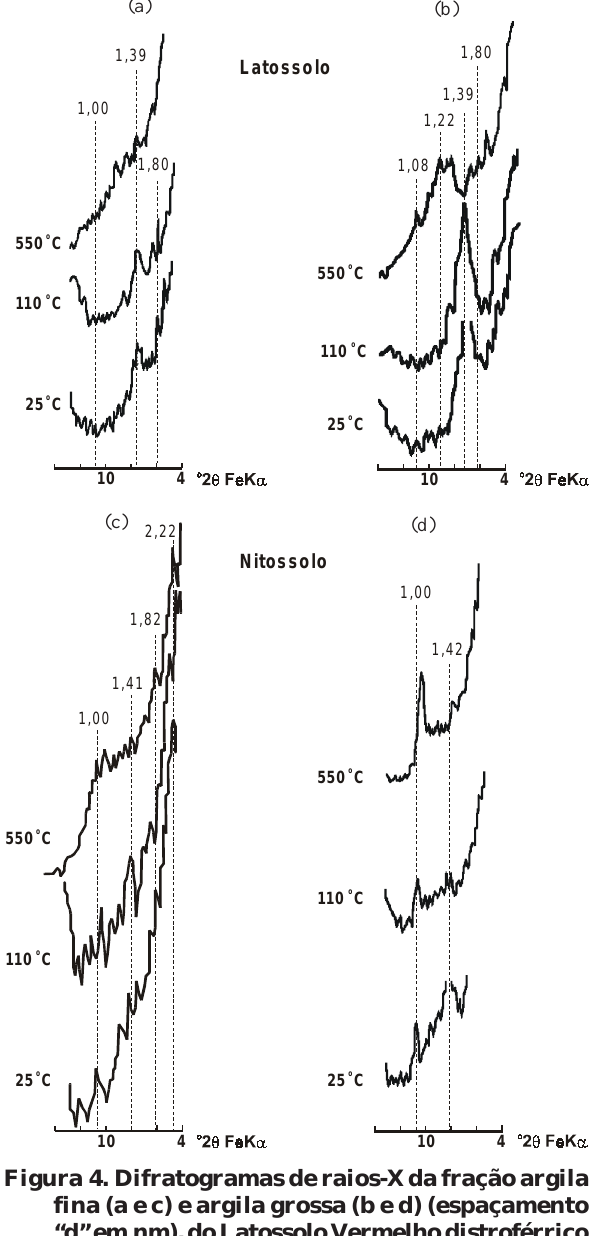
Figura 4. Difratogramas de raios-X da fração argila fina (a e c) e argila grossa (b e d) (espaçamento “d” em nm), do Latossolo Vermelho distroférrico típico (0–0,3 m) e do Nitossolo Vermelho distroférrico típico (0-0,15